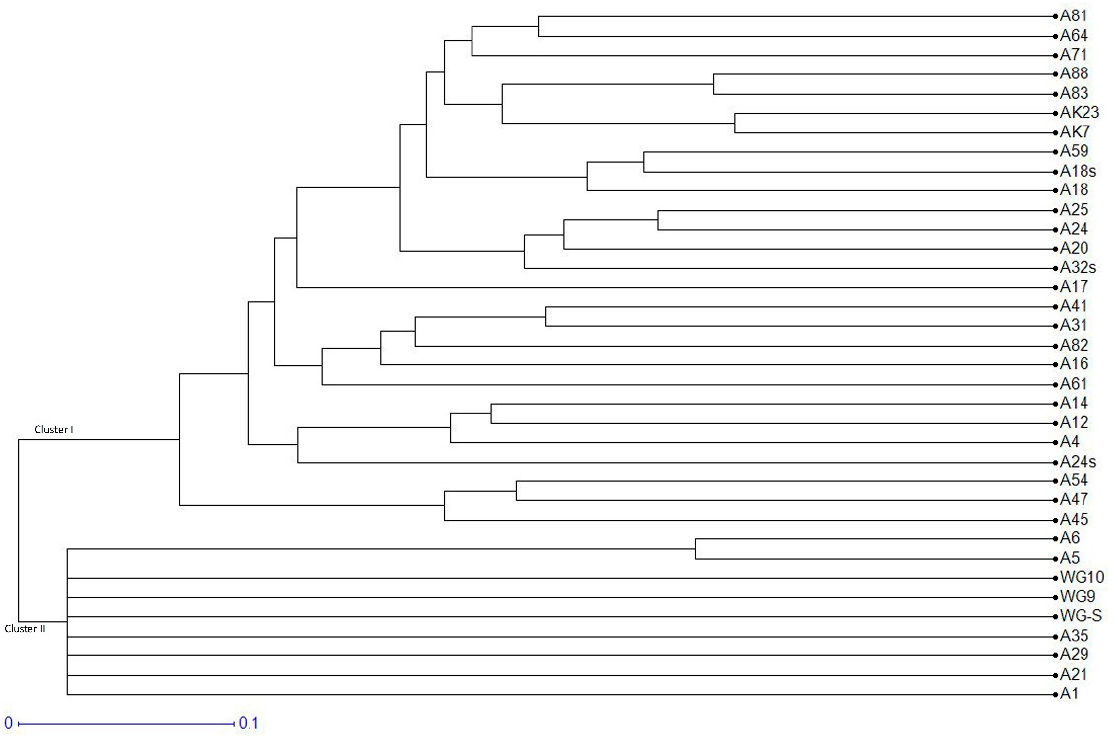
Figure 3. UPGMA dendrogram from SSR data of 36 isolates of Bipolaris sorokiniana amplified by 55 microsatellites.